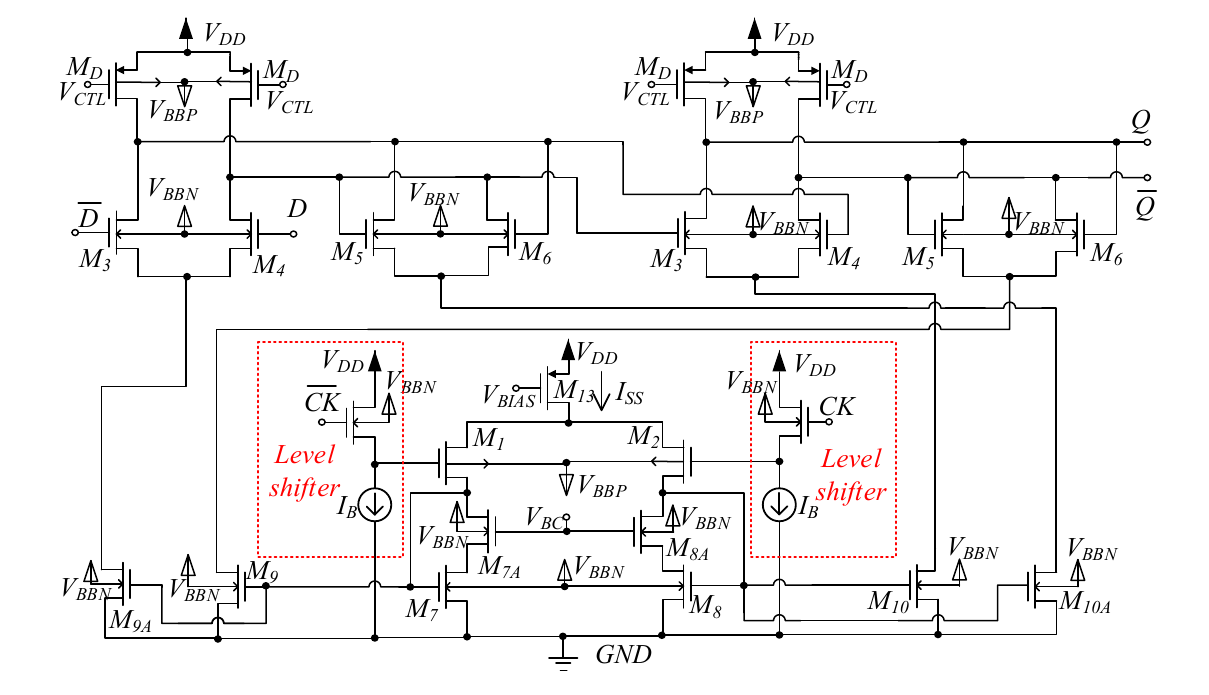
Figure 4. FMCML D flip-flop with FBB and input level shifter .